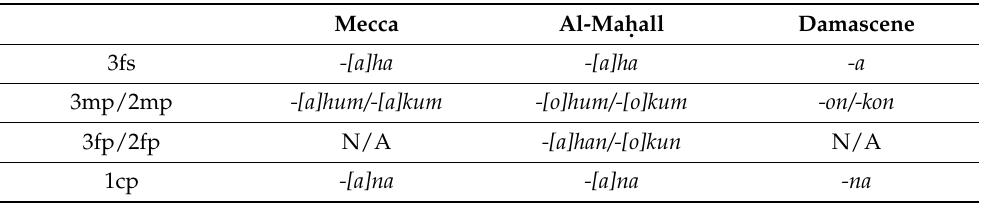
Table 5. Patterns of *-CVV and *CVC suffixes (Arabian data from Isaksson (1991); Damascene from Brustad and Zuniga (2019, p.